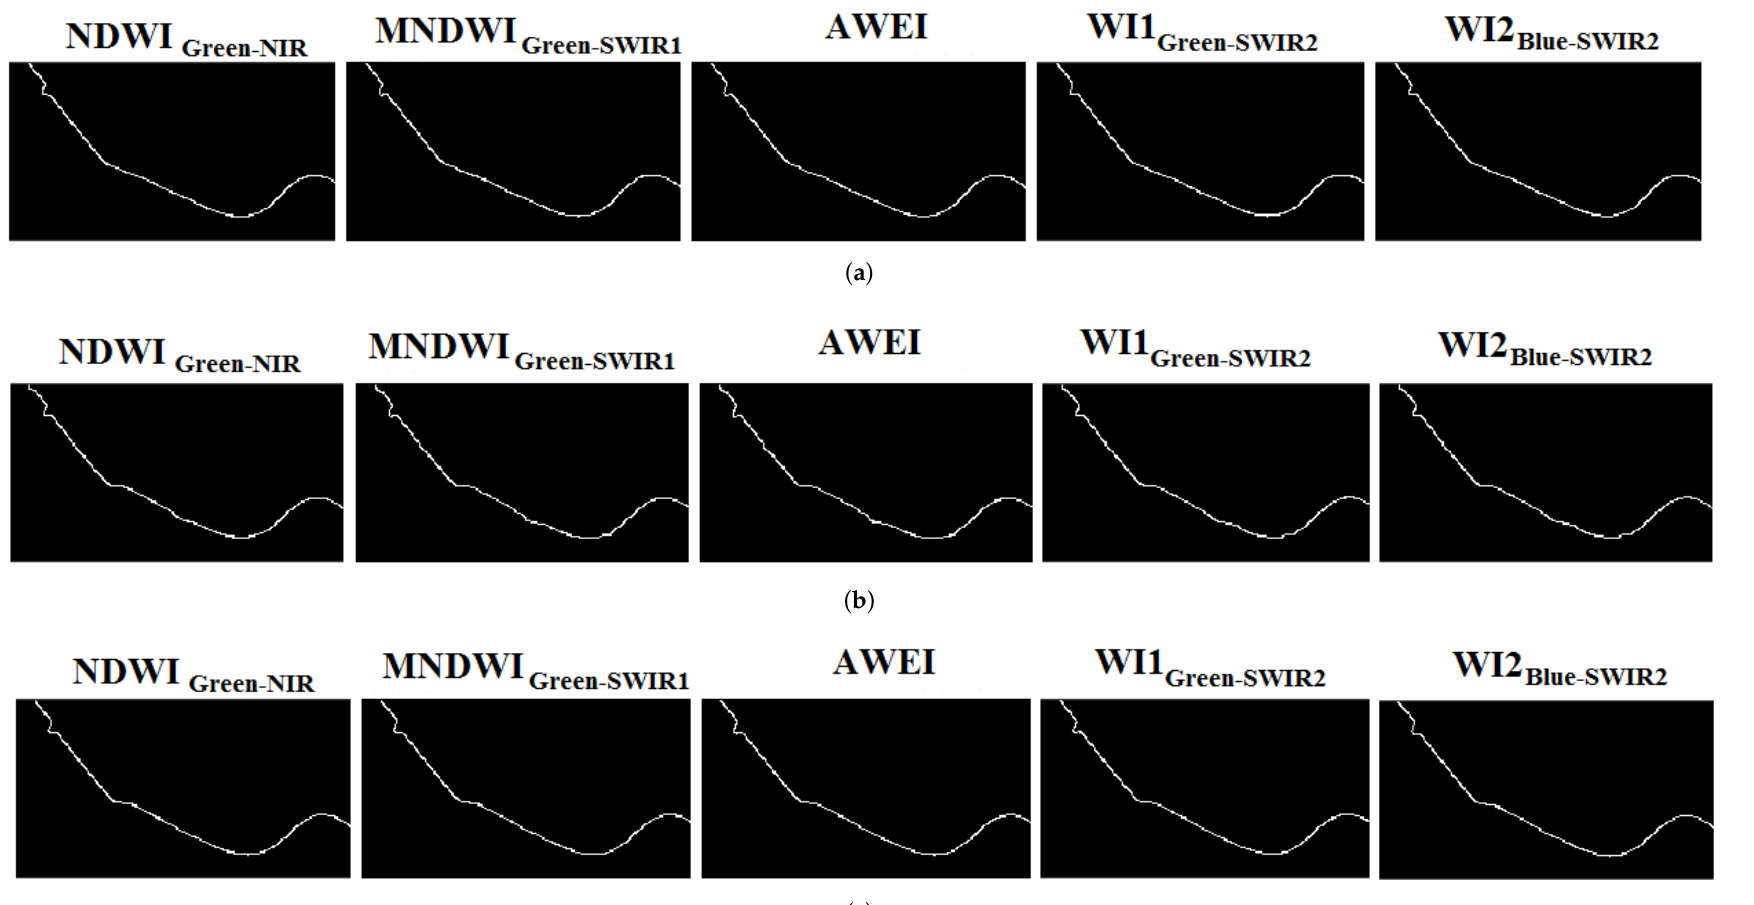
Figure 10. Shoreline extracted from images of different sensors in the Guadalfeo River Delta. ( a ) The shoreline detected on a TM image recorded on 17 September 2003. ( b ) The shoreline detected on an ETM+ image recorded on 20 September 2013. ( c ) The shoreline detected on an OLI image recorded on 12 September